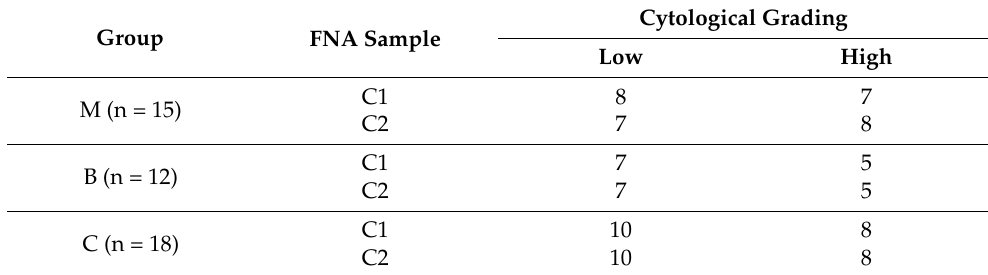
Table 2. Cytologic grading allocated in samples C1 and C2.